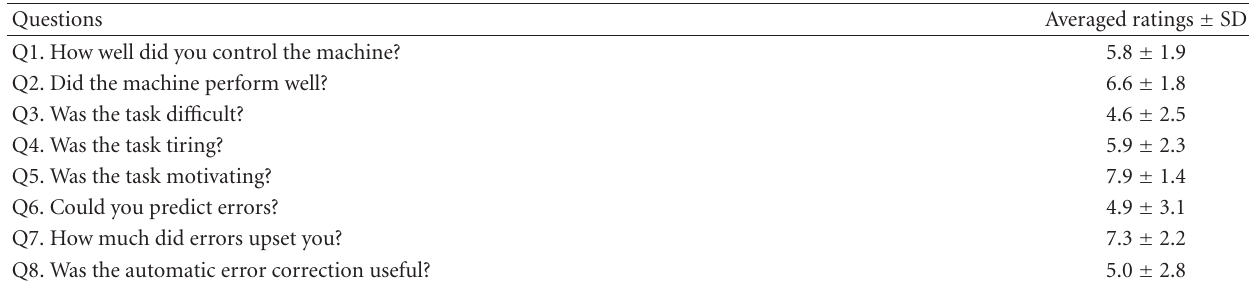
Table 3: Questionnaire and averaged ratings over the whole group ( N = 16). Ratings ranged between 1 (most negative response) and 10 (most positive